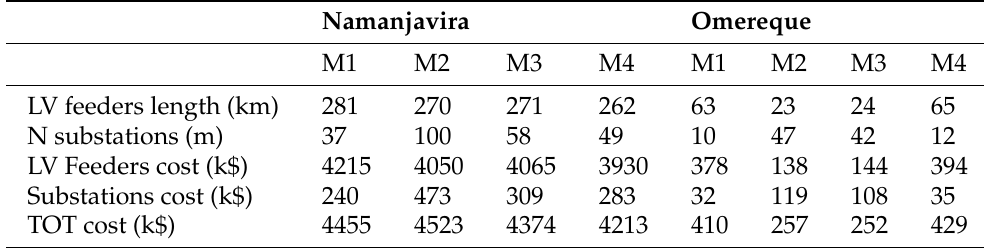
Table 5. Preliminary cost